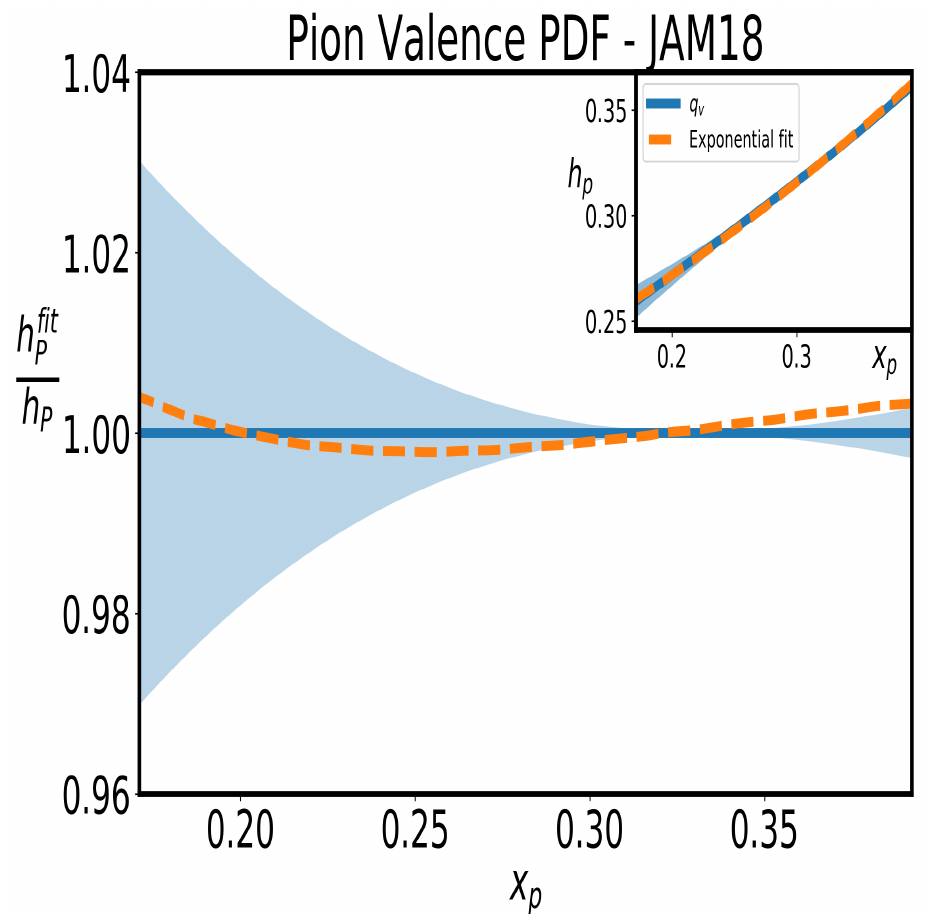
Figure 7. Ratio of exponential fit of the x p -dependence of h ( x p ) function using the parameterization of [21]. Dashed line is the fit according to Equation (10), solid line shows the central values and shaded area represents the error at 68% confidence level of parameterization. The insert shows the PDF h p function vs x p as well as the